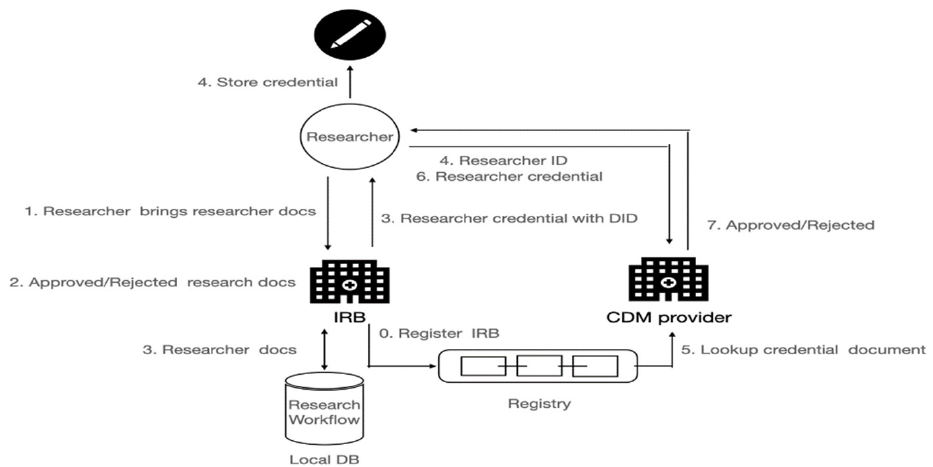
Figure 3. The is based on SSI-based Identity Management in a cloud CDM.